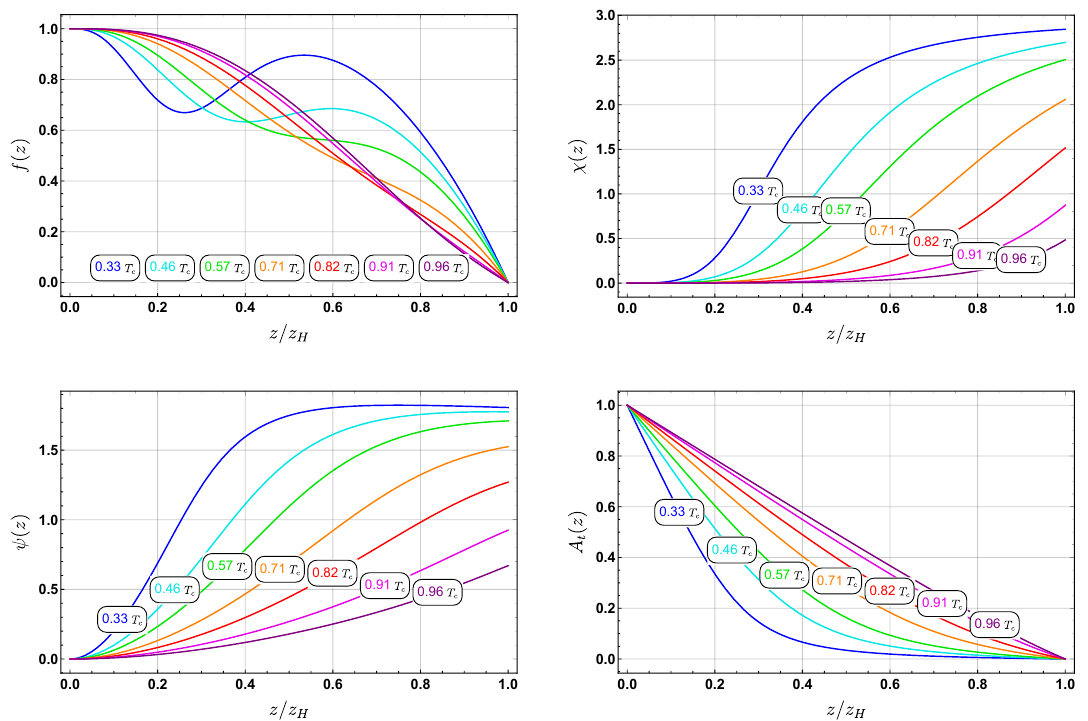
Figure 1 . The configuration of the charge black holes with scalar hair from the event horizon, z = z H , to the AdS boundary, z = 0 , at different temperatures. We have fixed the chemical potential µ = 1